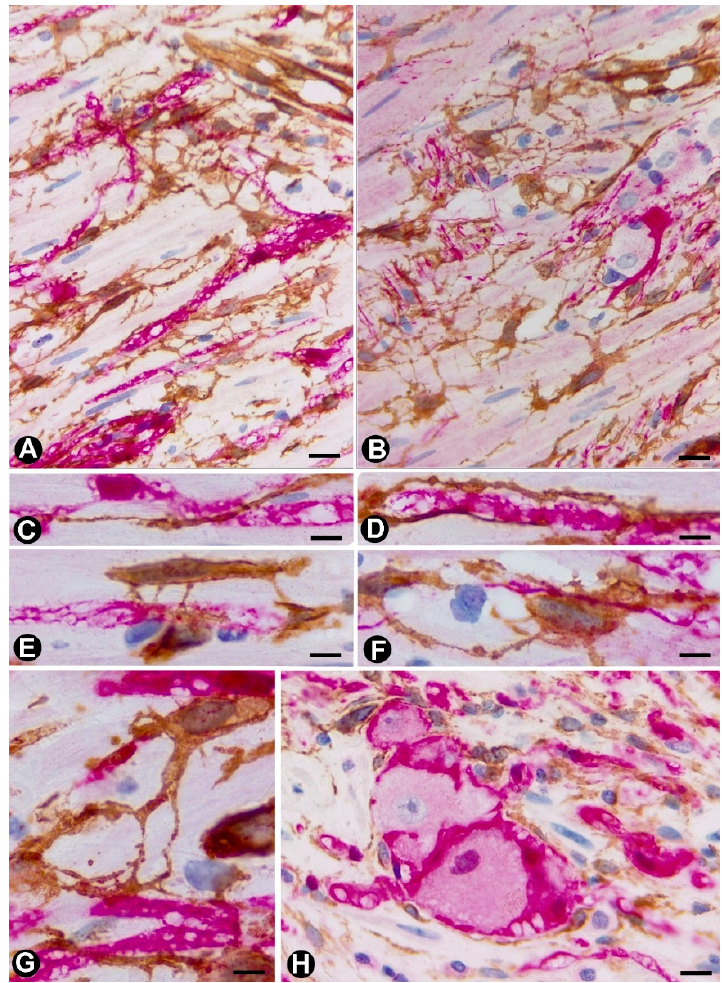
Figure 3. TCs/CD34+SCs (brown) around appendiceal hyperplastic nerve fibres (Schwann cells and axons) (red) ( A – G ) and neuronal–glial units ( B , H ). Sections stained with anti-CD34 (brown) and anti-S-100 (red) (A, C–E and G and H) and anti-CD34 and anti-neurofilaments (B and D). Numerous fusiform or stellate TCs and their telopodes (brown) are observed around the aforementioned structures. The TCs and telopodes follow the path of the nerve fibres and establish contact with TCs of other nerve fibres and smooth muscle cells. It should be noted how thinner telopodes can originate from the somatic region of the TCs (Figure 3E) or from thicker and initial telopodes (Figure 3G). Bar: A, B, 20 µm; C - H, 10 µm